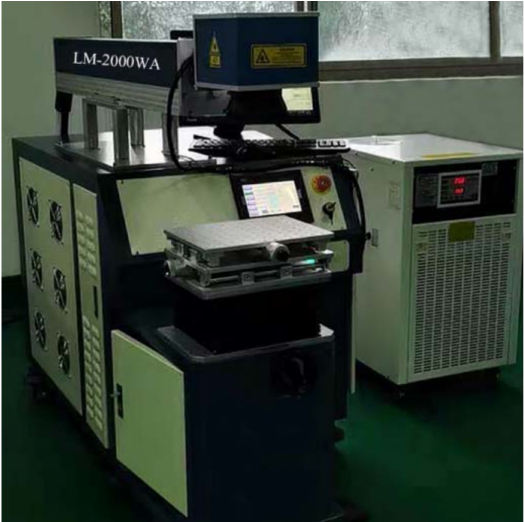
Figure 1. Physical image of the laser melting